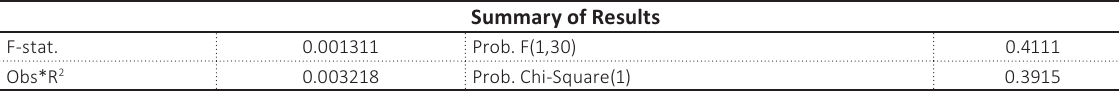
Table 4. ARDL summary